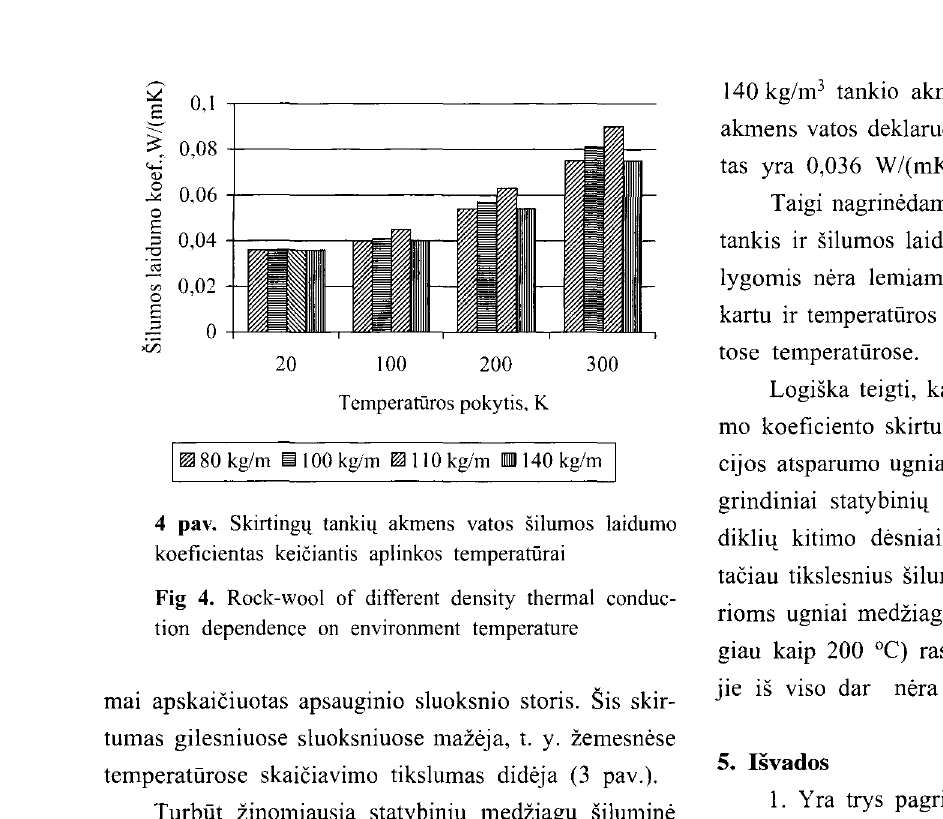
Fig 4. Rock-wool of different density thermal